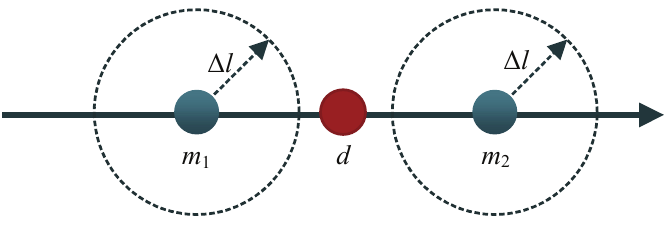
Figure 6. A small ∆ l incurring a failure of finding a corresponding point.